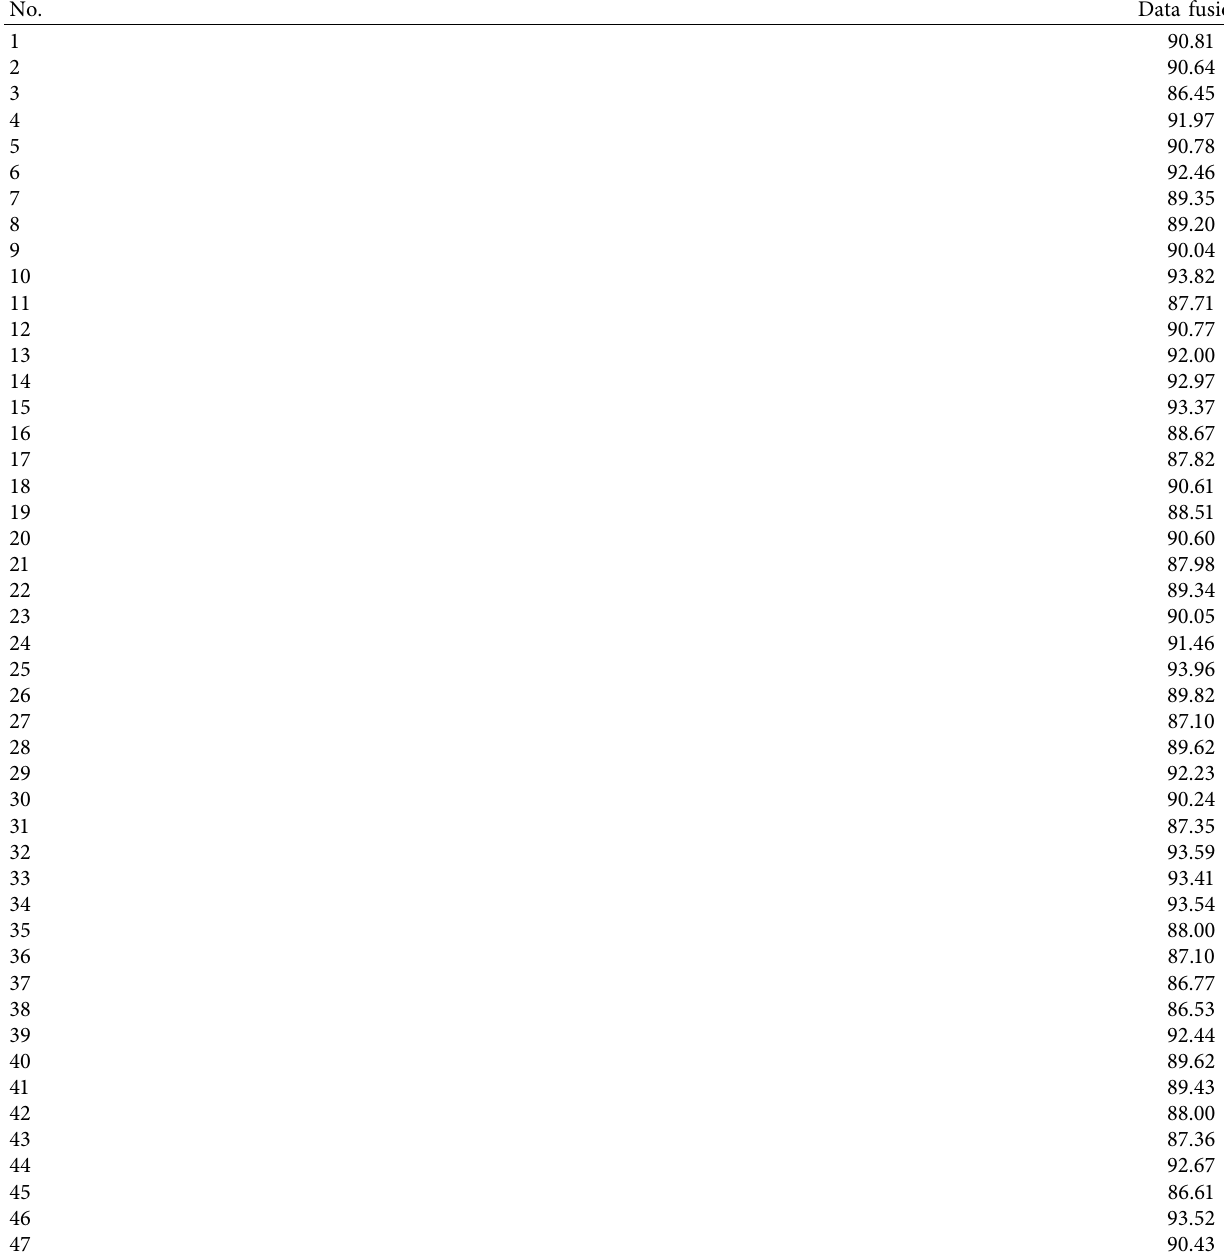
Table 1: Multivariate data-driven fusion